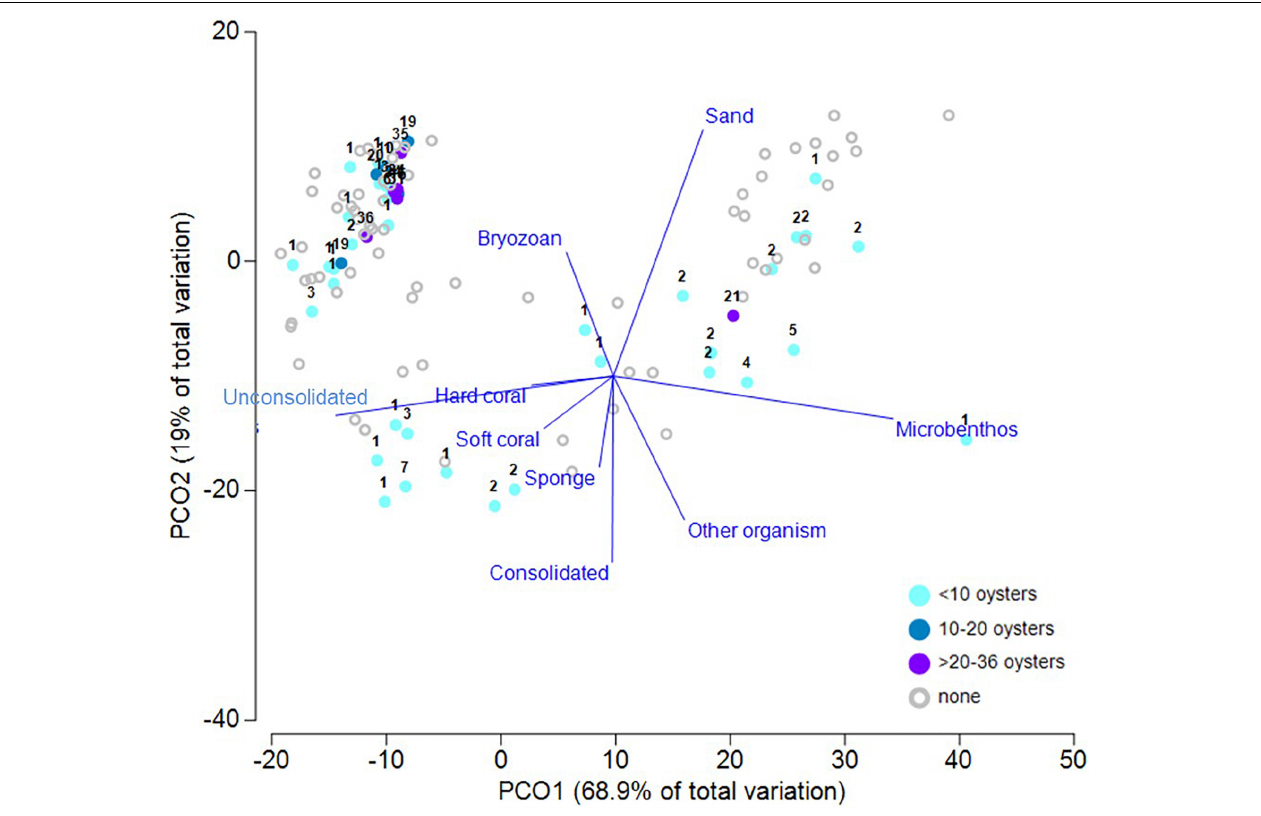
FIGURE 8 | Ordination plot following Principal Coordinates Analysis of P. maxima density and designated benthic groups observed in surveyed transects. Oyster density observed along each transect were binned into four arbitrary levels of density, as identified in the legend, and with additional information on actual numbers notated for each data point. Vectors are based on the raw Pearson correlations of variables with length >